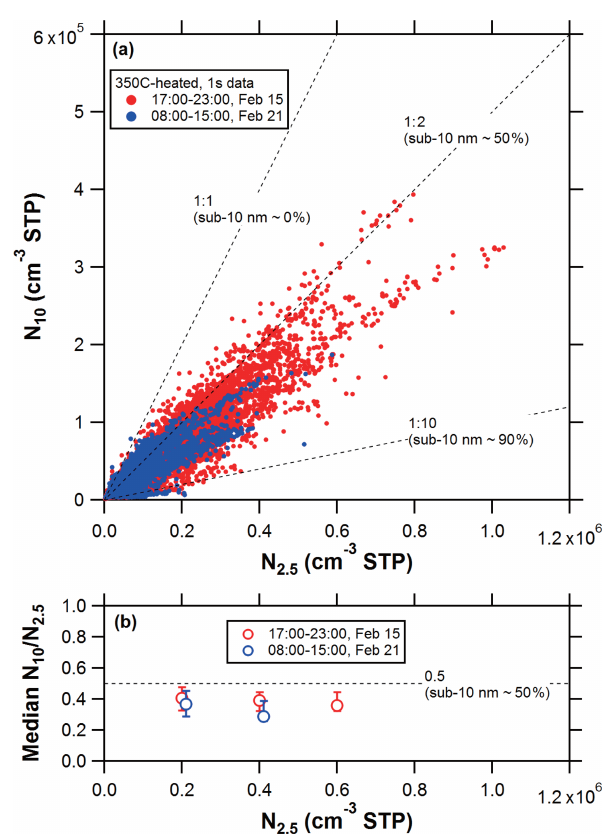
Figure 5. (a) Scatterplots of N 10 vs. N 2 . 5 for the 350 ◦ C heated mode. Data obtained on 15 February 2018 (red) and 21 February 2018 (blue) are shown. The 1 : 1 correspondence line ( N 10 = N 2 . 5 ) represents the state in which all particles are included in the size range larger than 10nm. (b) Median values of the N 10 /N 2 . 5 ratios for the N 2 . 5 bin of (1–3 ) × 10 5 , (3–5 ) × 10 5 , and (5–7 ) × 10 5 cal- culated by using the data shown in (a) . The error bars represent the 25th and 75th percentile